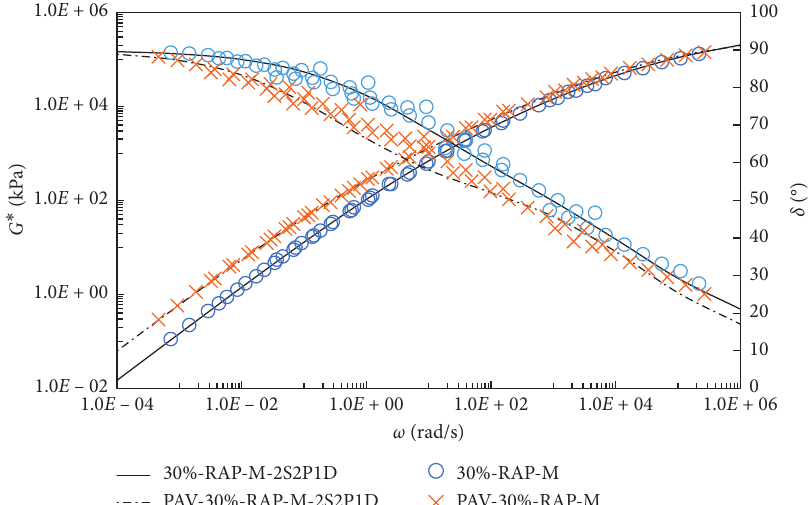
Figure 8: Complex shear modulus and phase angles master curves for RAP-M binder containing 30% RAP binder before and after PAV